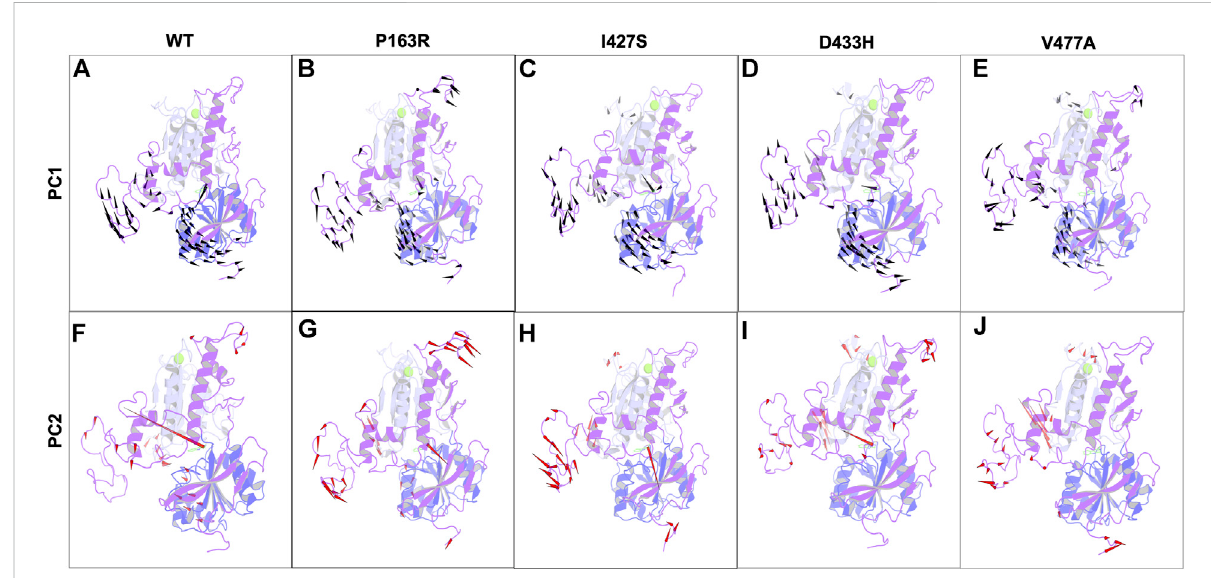
FIGURE 10 Porcupine plots for the fi rst two principal components from essential dynamics of WT, and mutant P163R, I427S, D433H, and V477A MD simulation trajectories. Spikes for PC1 (Black) and PC2 (Red) originate from C-alpha atoms and represent the directionality of motions. The magnitude of spikes indicates the strength of